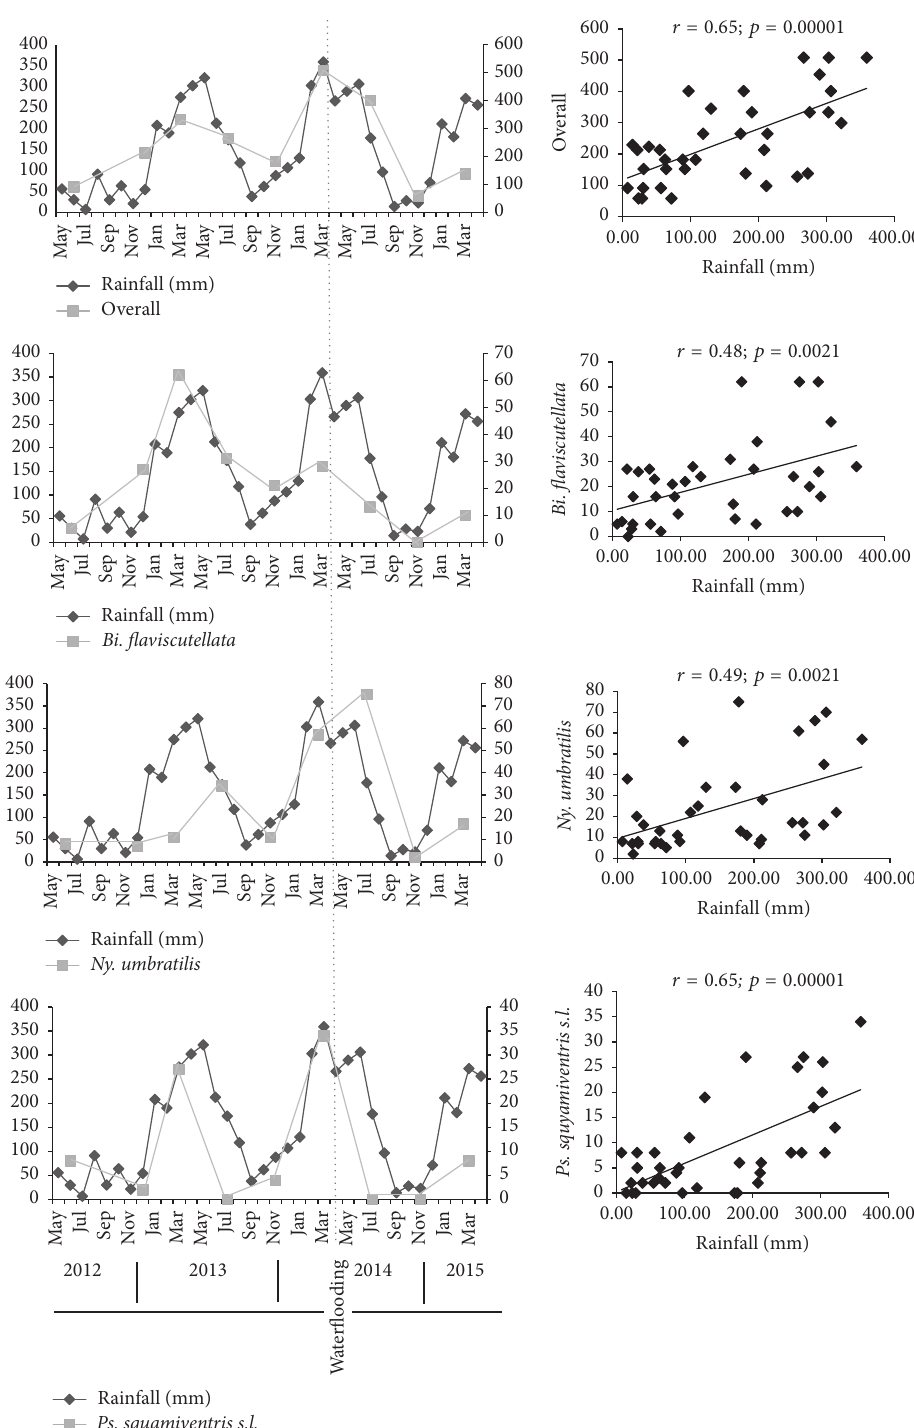
Figure 3: Correlation between rainfall and phlebotomine putative vector species captured in Santo Antˆonio do Jari hydroelectric system impacted area, between the states of Par´a and Amap´a, Brazil